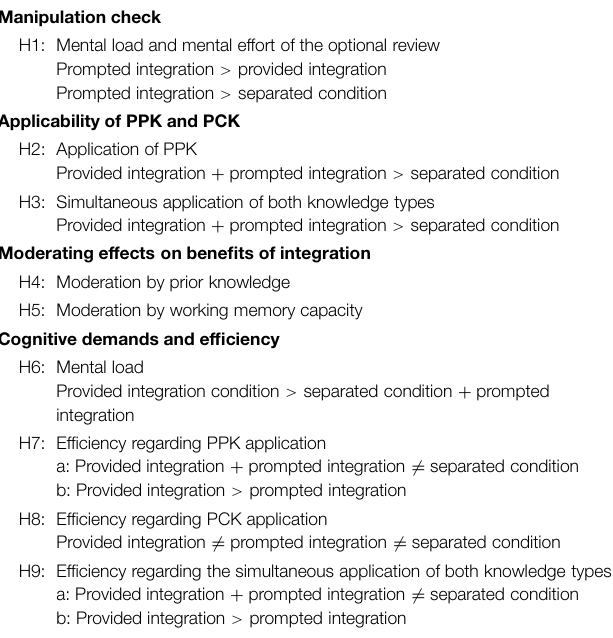
TABLE 1 | Overview of the